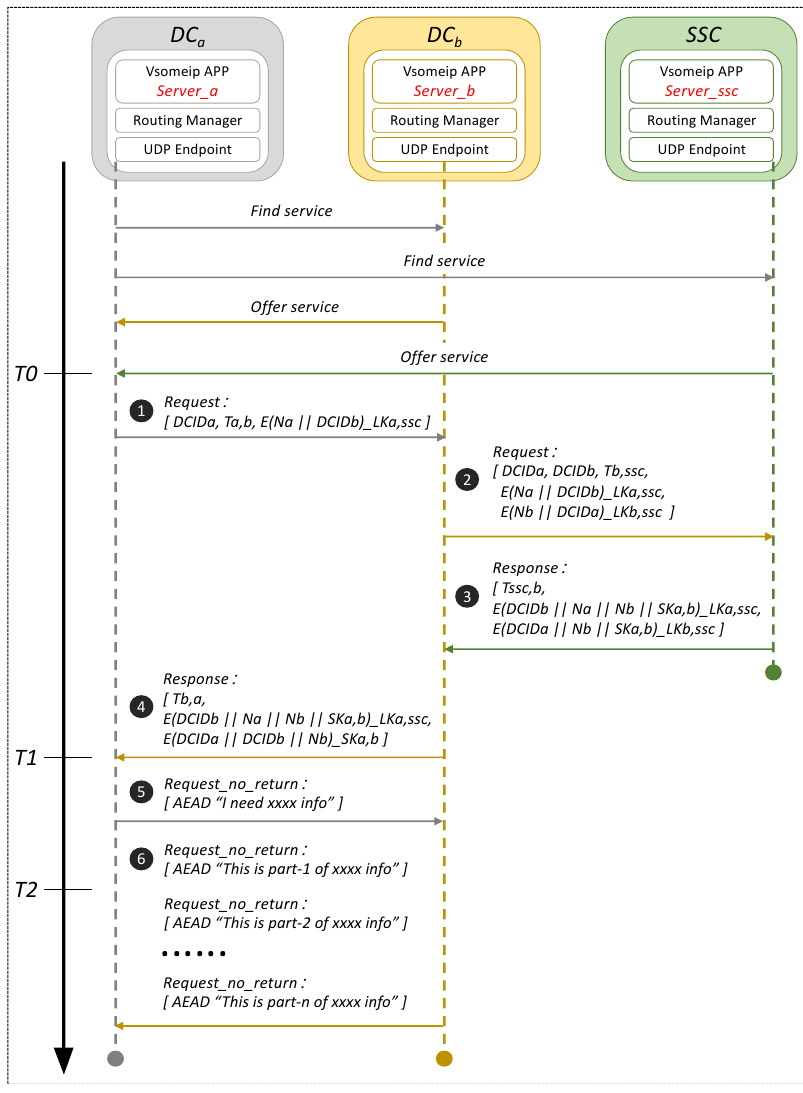
Figure 10. Data transmission process of the experimental program.